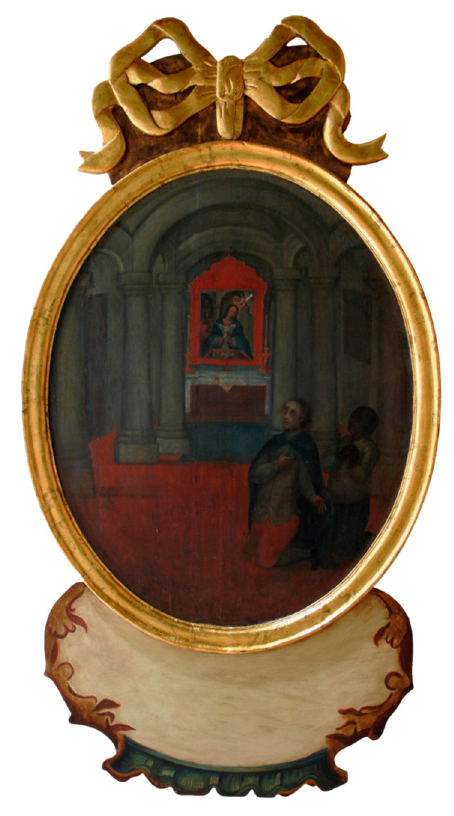
Figure 10. Enslaved Mute , Altagracia miracle medallion, oil on panel, c. 1760–1778, Museo de Altagracia, Higüey, Dominican Republic. Used with permission from Museo de Altagracia.